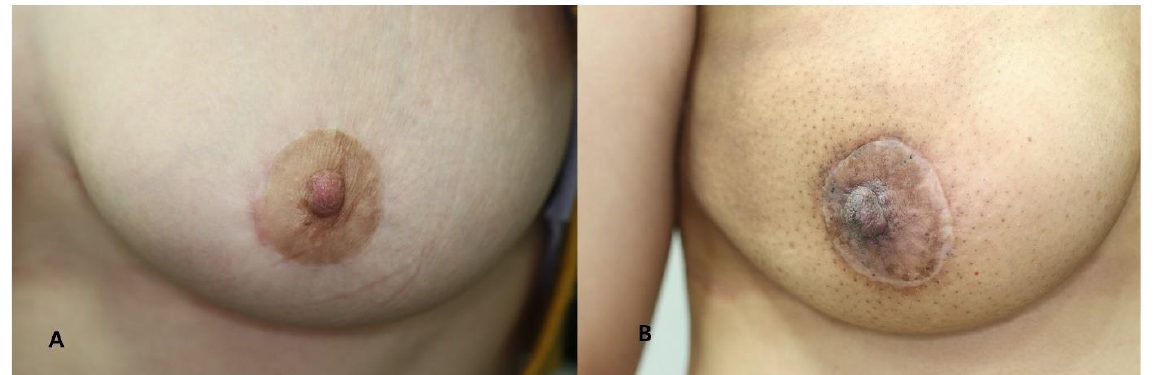
Figure 4. Clinical photographs taken at 12 months postoperatively. ( A ) A 39-year-old female patient assigned to the good scar group (VSS score: 0). ( B ) A 47-year-old female patient assigned to the poor scar group (VSS score: